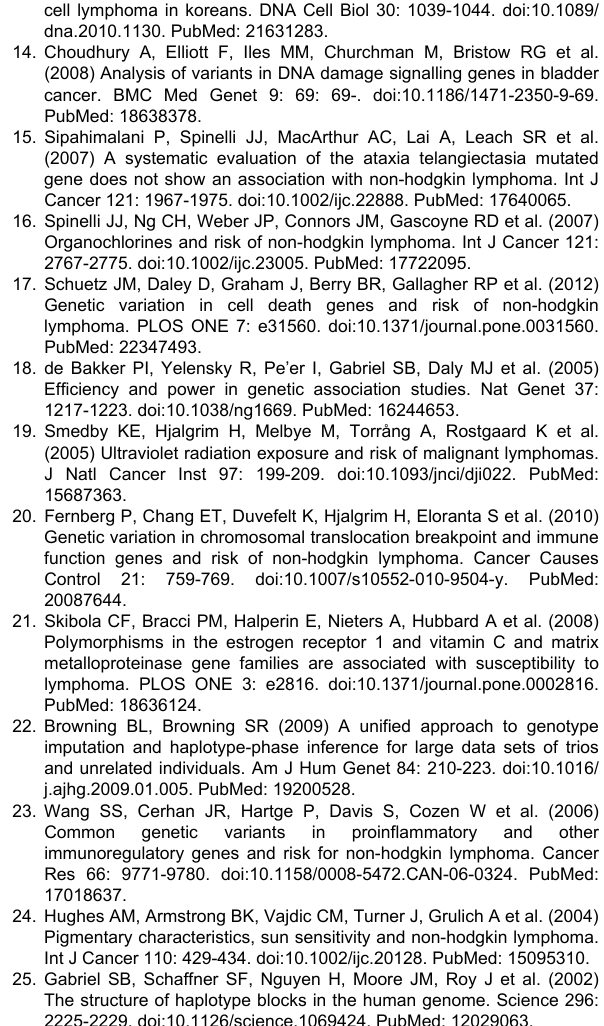
Table S2. Characteristics of study populations included in meta-analysis.